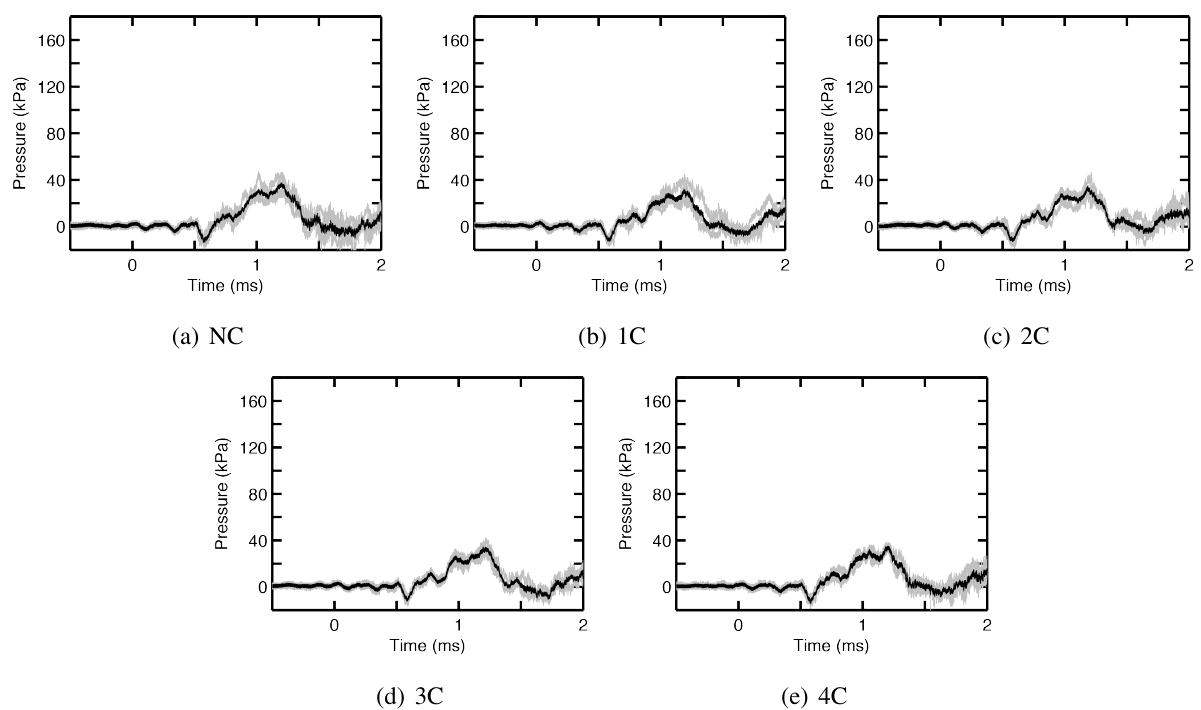
Figure A7. Closed cell foam pressure recordings for all cases: transmitted